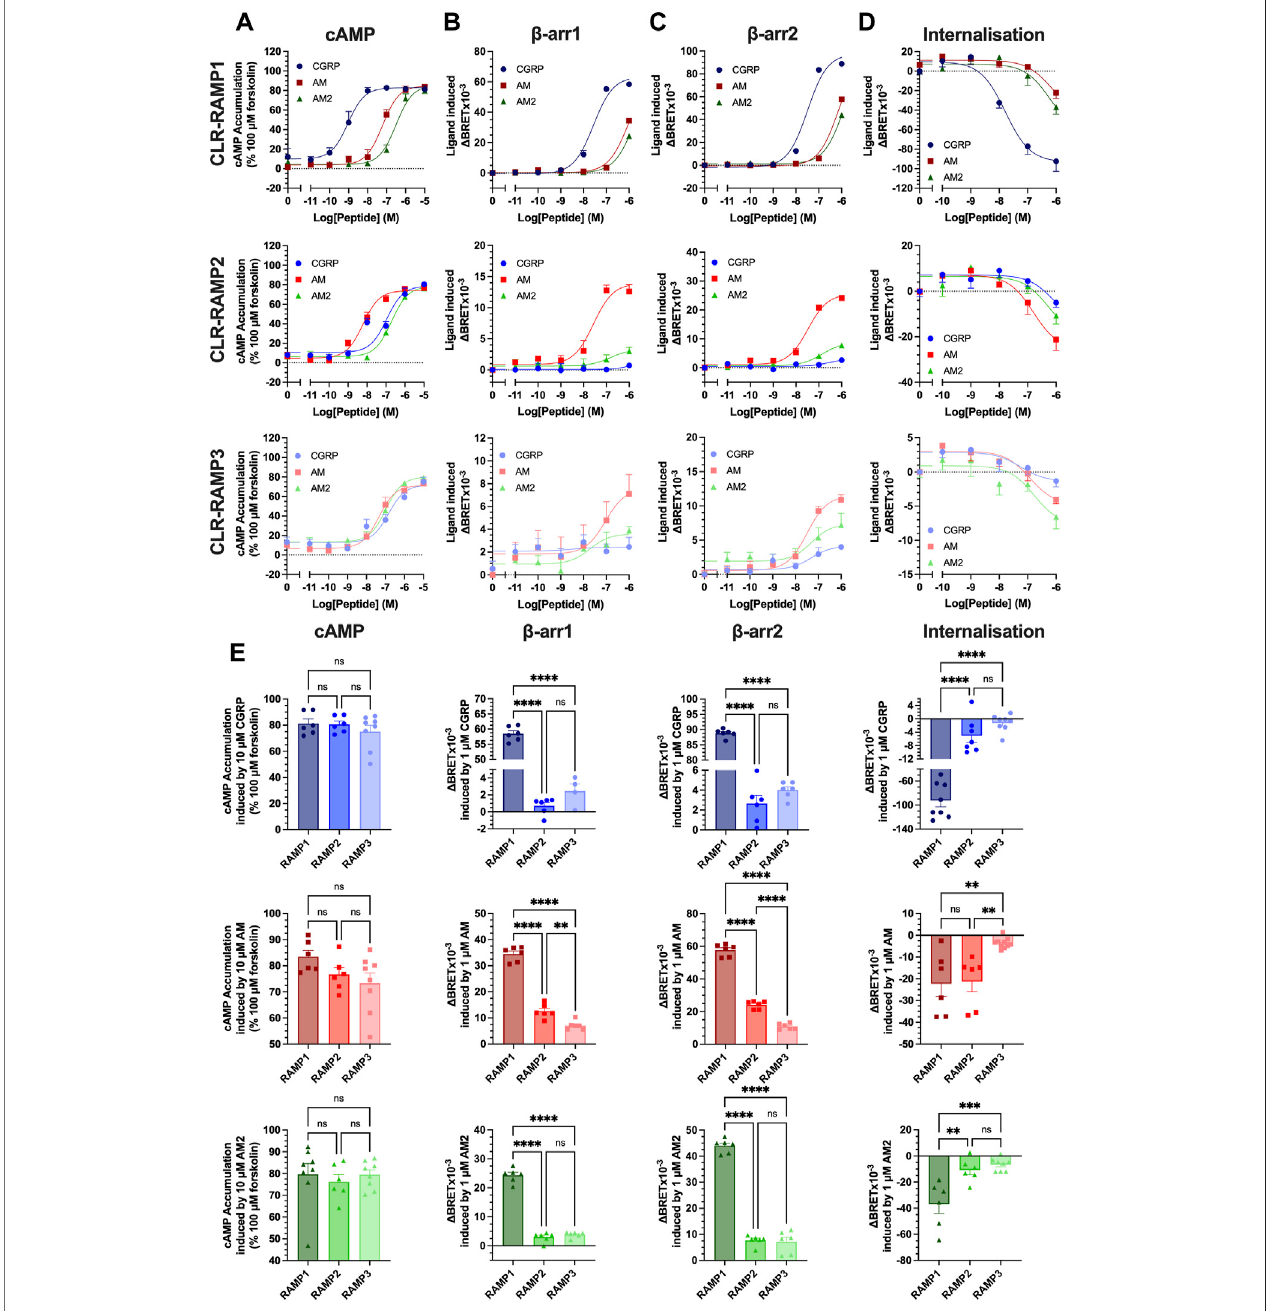
FIGURE1| OnlycognateagonistsofCLR-RAMPcomplexesrecruit β -arrestinsandinduceinternalisation.HEK293TcellsexpressingCLR-RAMPcomplexeswere assayed for cAMP accumulation (A) , β -arrestin1 (B) , β -arrestin2 (C) recruitment, and internalisation (D) at CLR in complex with RAMP1, RAMP2, and RAMP3. (E) Responses to 10 μ M or 1 μ M CGRP, AM, and AM2 at cAMP, β -arrestin1, β -arrestin2, and internalisation. Statistical signi fi cance between RAMPs for each peptide was determined,at p < 0.05,throughOne-WayANOVAwithDunnett ’ spost-test(*, p < 0.05;**, p < 0.01;***, p < 0.001;****, p < 0.0001).Dataareshownasmeanwith error bars indicating the SEM of n repeats where n ranges between 3 and 5 duplicates.